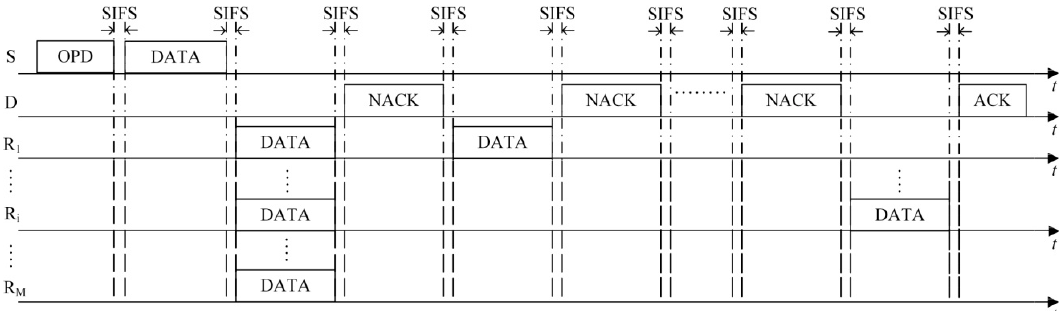
Figure 8. Successful data packet transmission after multiple retransmissions.